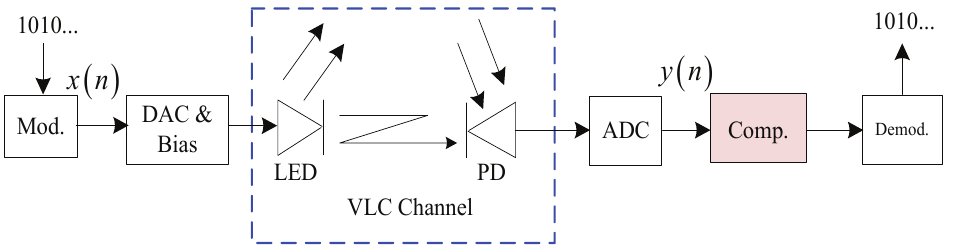
Figure 1. Block diagram of VLC system with an IM/DD